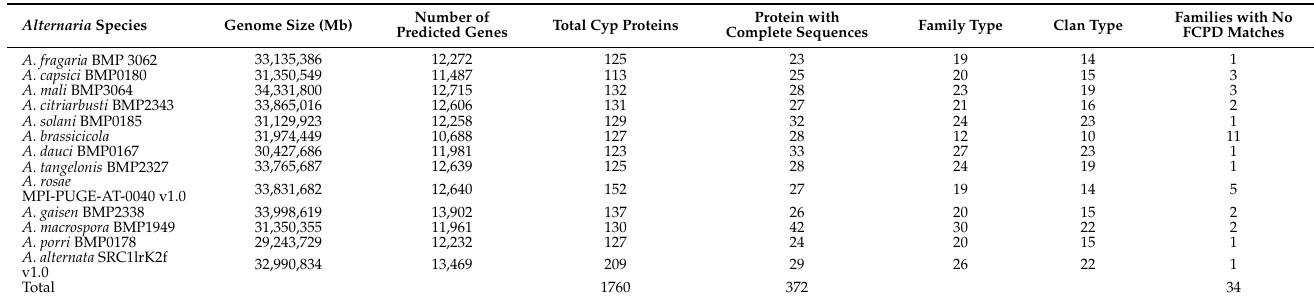
Table 1. Taxonomic distribution of putative CYPs in thirteen Alternaria species. Alternaria Species GenomeSize(Mb) Numberof PredictedGenes TotalCypProteins Proteinwith CompleteSequences FamilyType ClanType FamilieswithNo